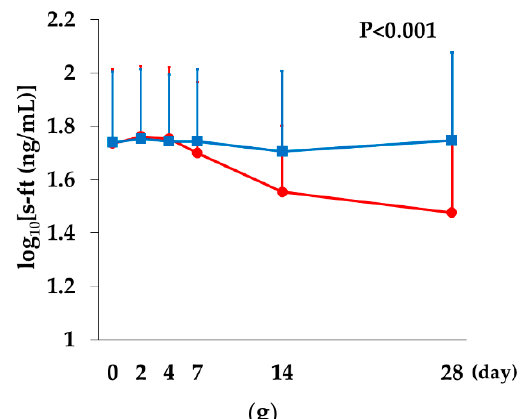
Figure 6. Comparison between the Rox and DA groups . ( a ) Ret count showed a significant difference between the groups ( p = 0.001). ( b ) CHr showed no significant difference between the groups ( p = 0.99). ( c ) Log 10 (hepcidin) showed a significant difference between the groups ( p = 0.002). ( d ) s-Fe showed a significant difference between the groups ( p = 0.001). ( e ) TSAT showed a significant difference between the groups ( p < 0.001). ( f ) TIBC showed a significant difference between the groups ( p < 0.001). ( g ) Log 10 (s-ft) showed a significant difference between the groups ( p < 0.001). Two-way repeated measures analysis of variance was performed. The data are represented as mean ± SD. ( Rox, DA).